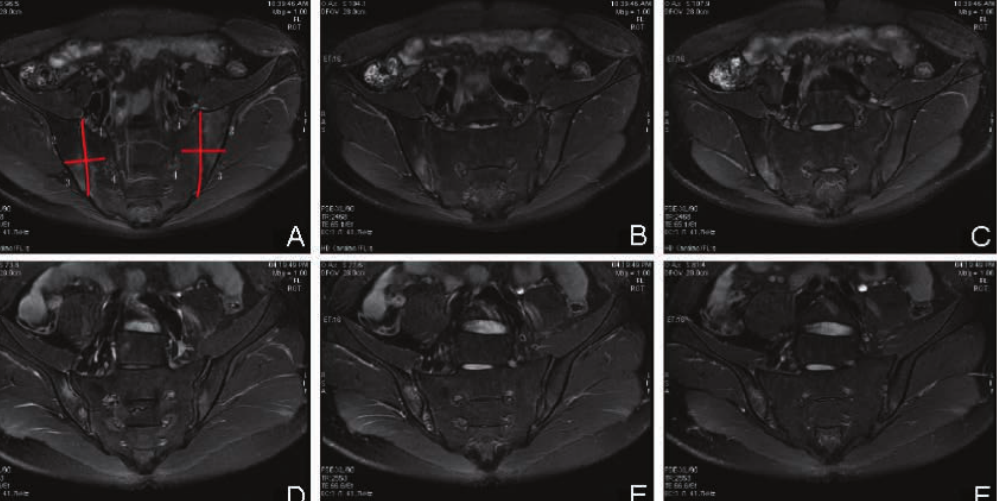
Figure 4: SPARCC scoring comparison of bone marrow edema before and after treatment in AS patients. Scoring of A, B and C (before treat- ment): 10, 8, 9; scoring of D, E and F (after treatment): 7, 5, 5. The scoring of bone marrow edema decreased significantly after treatment, showing reduced bone marrow edema and an effective